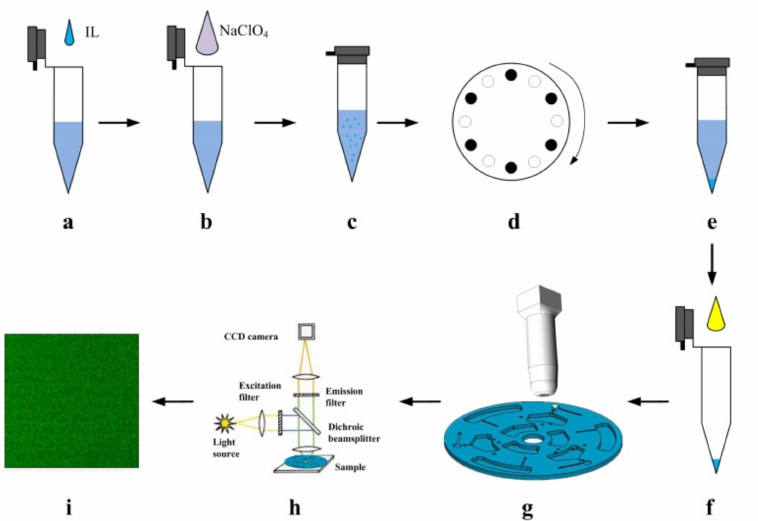
Figure 7. Conceptualillustrationofthesalt-controlledionicliquiddispersiveliquid-liquidmicroextraction fluorescence detection (SC-IL-DLLME-FD) process steps: ( a ) The mercury solution dissolved ionic liquid (IL), achieving saturated IL aqueous solution. ( b ) NaClO 4 was added. ( c ) IL micro-droplets suspended in the emulsion. ( d ) Centrifugation. ( e ) Separation. ( f ) IL phase was mixed with acetonitrile (ACN) and aqueous solution containing para-position tetraphenylethenerhodamine (PTR) probe. ( g ) Reaction at 55 ◦ C for one hour. ( h ) Mercury ion was quantified through fluorescence microscope. ( i ) Resulting fluorescent images.